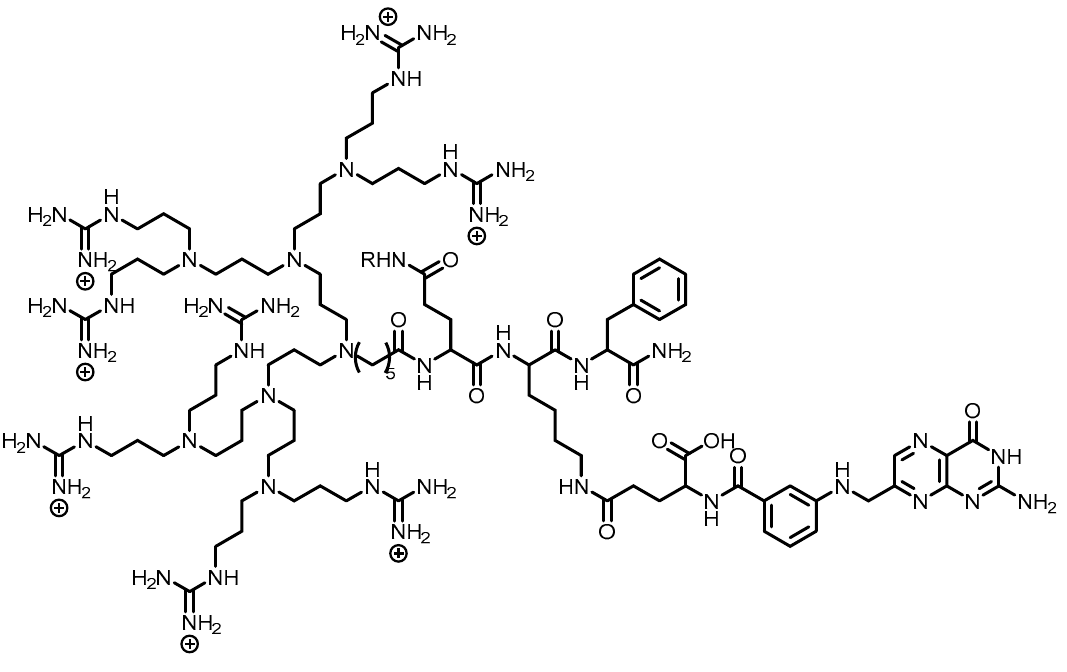
Figure 4. Chemical structure of G8-FKE-FA-DOX [44].